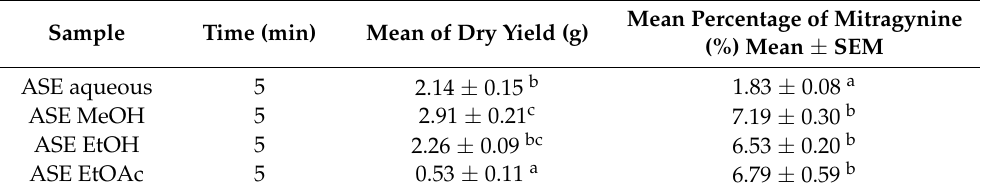
Table 2. Dry yield and mitragynine content in M. speciosa ASE leaves extracted, respectively, with 100% of water, MeOH, EtOH, and EtOAc.